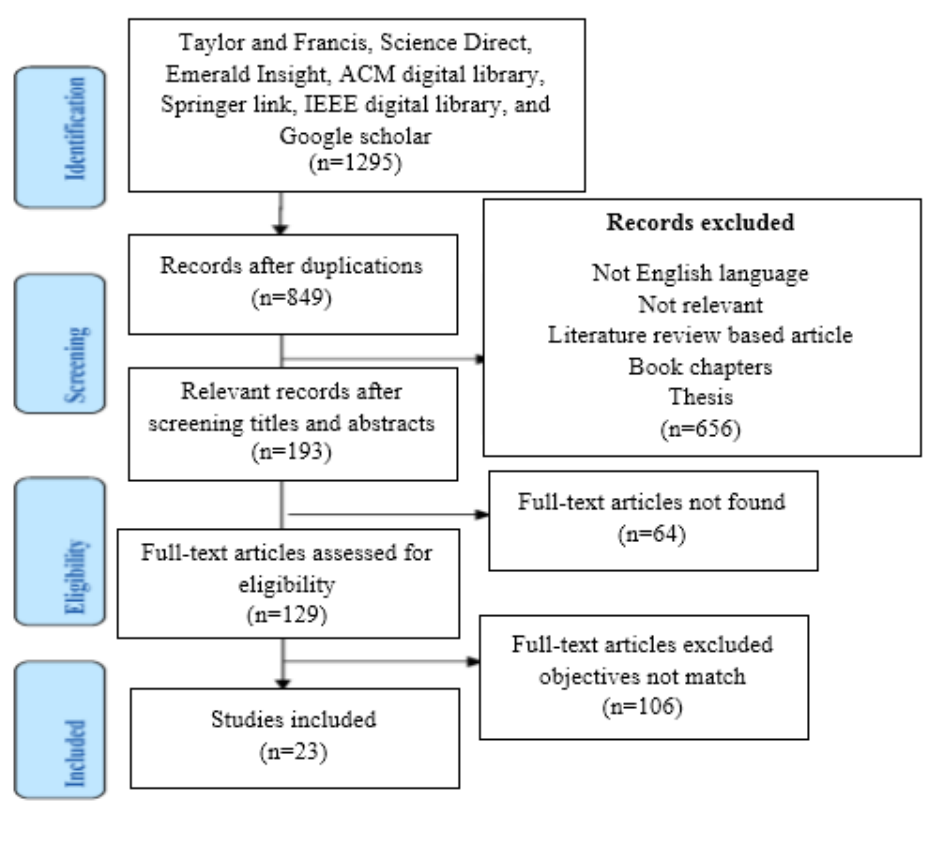
Figure 1: Flow Diagram of Selection Process of